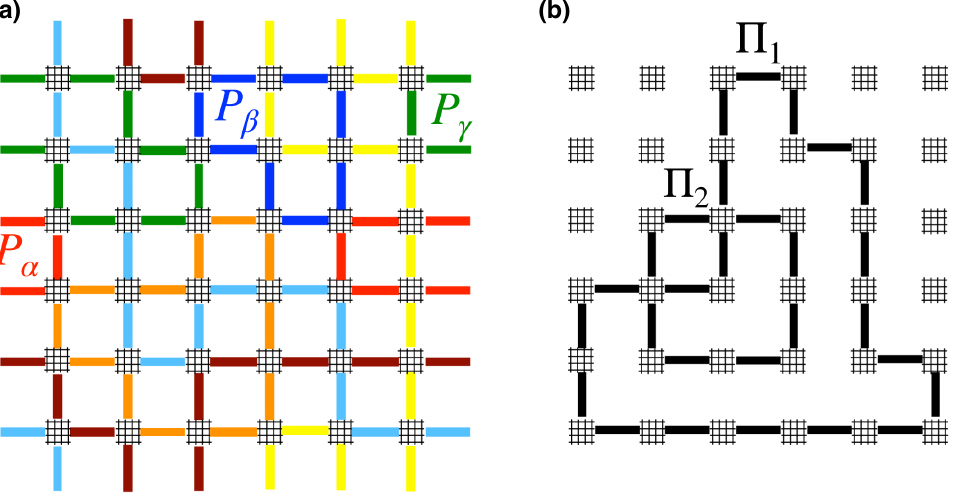
FIG. 3. (a) Example of the U ( 1 ) loop covering in the superconducting wire array. Values of equal θ are represented by different colors, and loops wrap around with periodic boundary conditions (e.g., θ = α , β , and γ label three loops P colored red, blue, and green, respectively). Other colored loops fully fill the lattice. Loops can intersect. (b) Example of the second kind of loop (cid:11) , which adds a phase π to each of the links visited. Any such loop is a direct result of the local Z 2 gauge symmetry and can be superimposed on any loop covering in